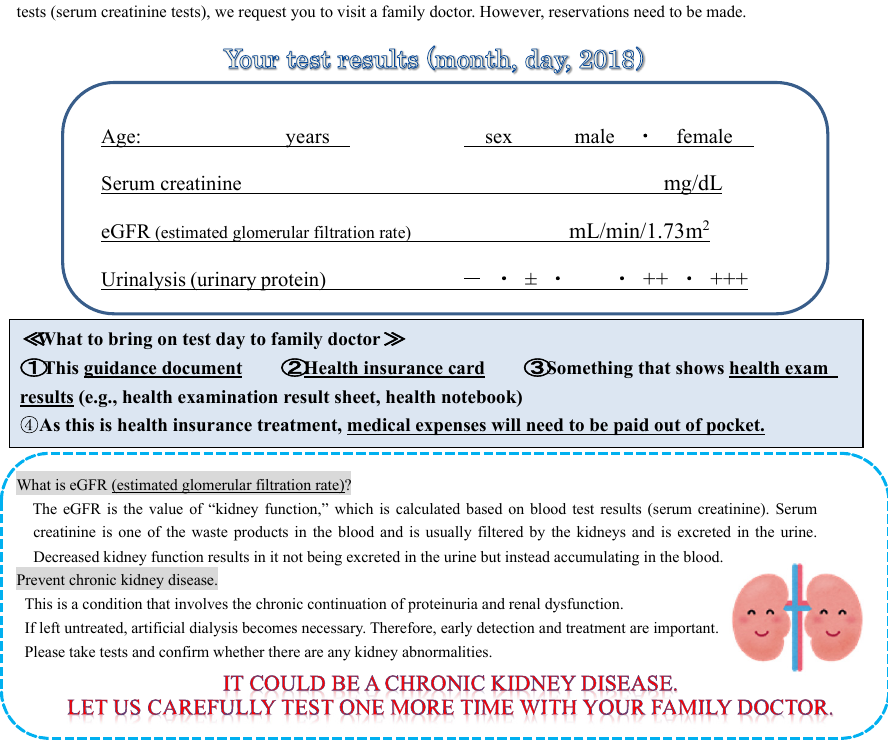
Figure 2. Re-examination through specific health checkups (guidance).